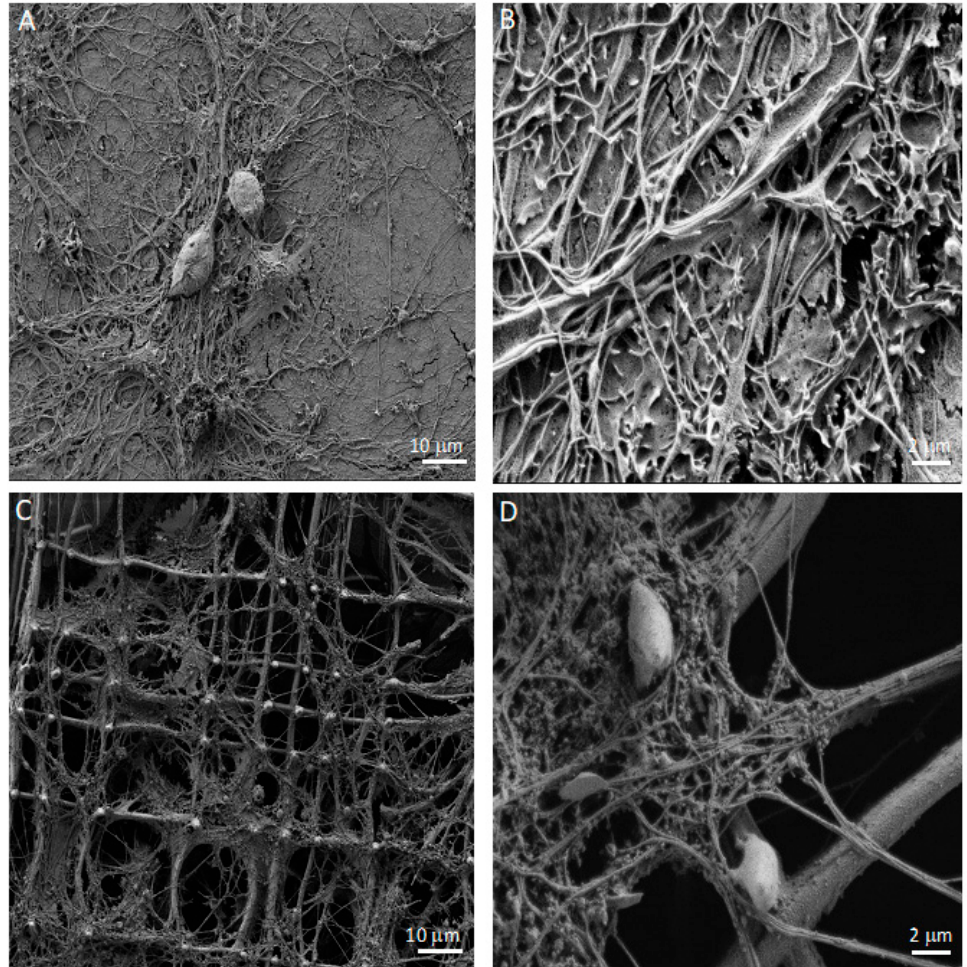
Figure 4. SEM microscopy of DIV21 hippocampal astrocyte and neuron co-cultures in 2D and in the 3D synthetic microscaffold Nichoid. ( A ) The 2D hippocampal astrocyte and neuron co-culture. Scale bar of 10 µ m. ( B ) Higher magnification of 2D hippocampal astrocyte and neuron co-culture. Scale bar of 2 µ m. ( C ) The 3D hippocampal astrocyte and neuron co-culture in the Nichoid. Scale bar of 10 µ m. ( D ) Higher magnification of 3D hippocampal astrocyte and neuron co-culture in the Nichoid. Scale bar of 2 µ m.